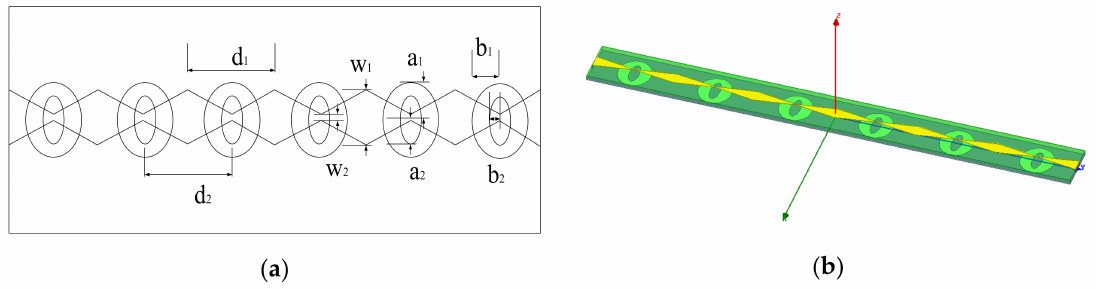
Figure 6. ( a ) Perspective view of a microstrip band stop filter etching of a periodic elliptical ring EBGs; ( b ) 3D picture of a microstrip band stop filter etching of a periodic elliptical ring EBGs.